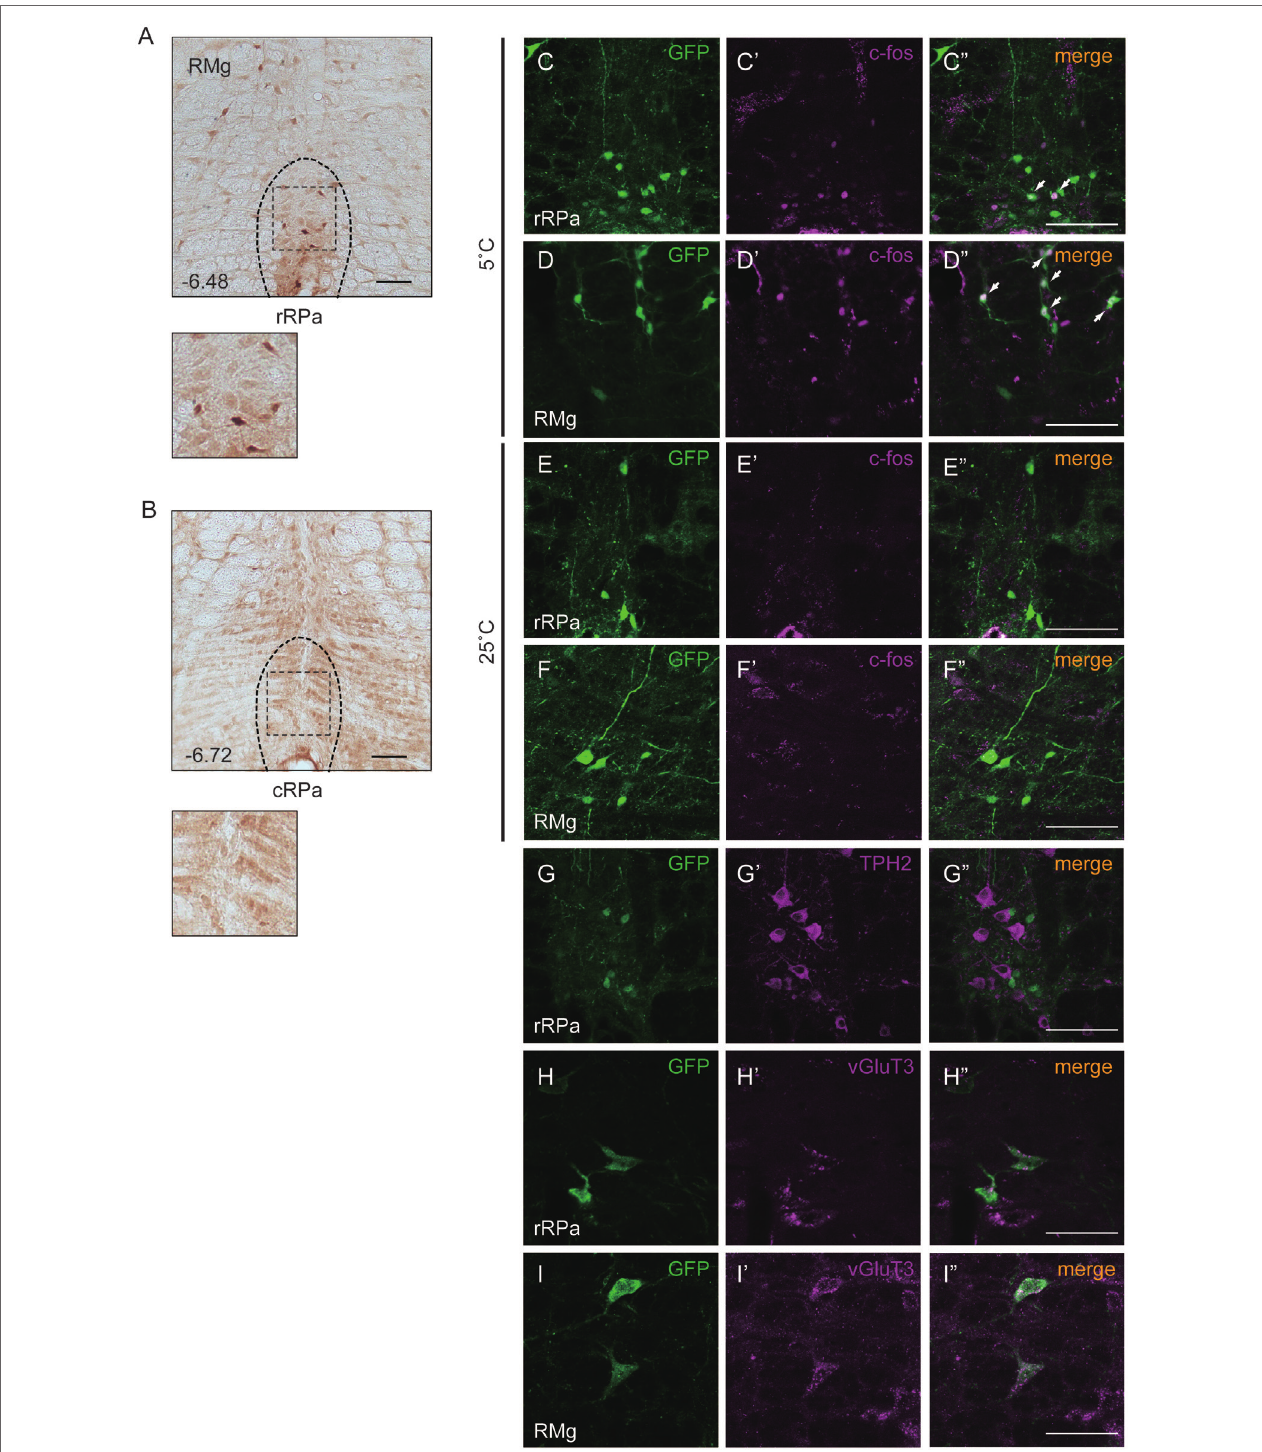
FigUre 1 | Oxtr expressed neurons in the rostral raphe pallidus (rrPa) were activated by cold exposure . (a,B) Cryosections of the RPa, indicating which of the Oxtr-Venus mice were immunostained with anti-GFP. Oxtr was mostly expressed in the rRPa (a) , but not in the caudal raphe pallidus (cRPa) (B) . Distance from bregma (millimeter) is indicated in the figure panel. (c–F) Oxtr-expressing neurons were activated during the cold condition, but not under normal conditions in the rRPa and RMG. Samples were immunostained with anti-GFP (green), anti-c-Fos (magenta), and merged. The arrows indicate neurons expressing both Venus and c-Fos. (g–i) Oxtr-expressing neurons were immunostained using both glutamatergic markers (vGluT3) and serotonergic markers (TPH2). Scale bar: 100 μ m (a–g) , 50 μ m (h,i)